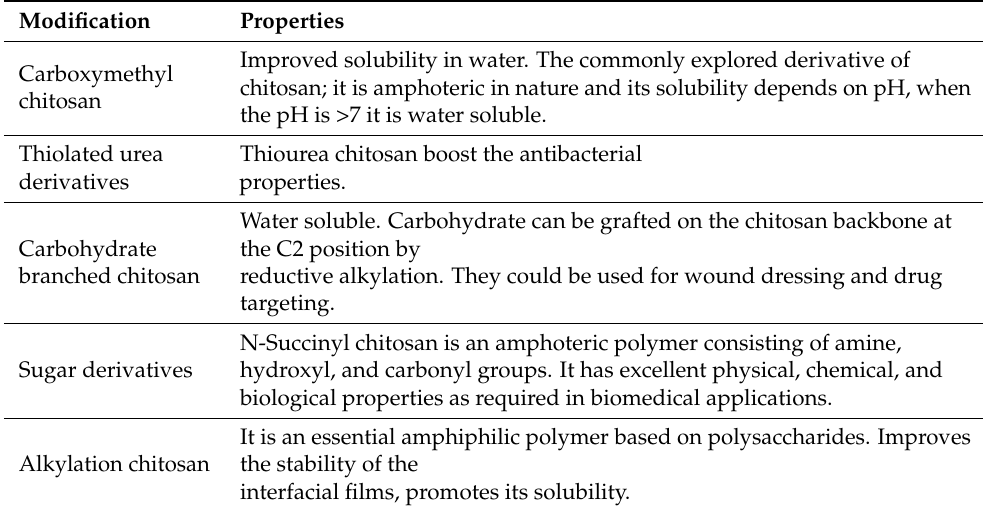
Table 1. Some common modification of chitosan for wound healing